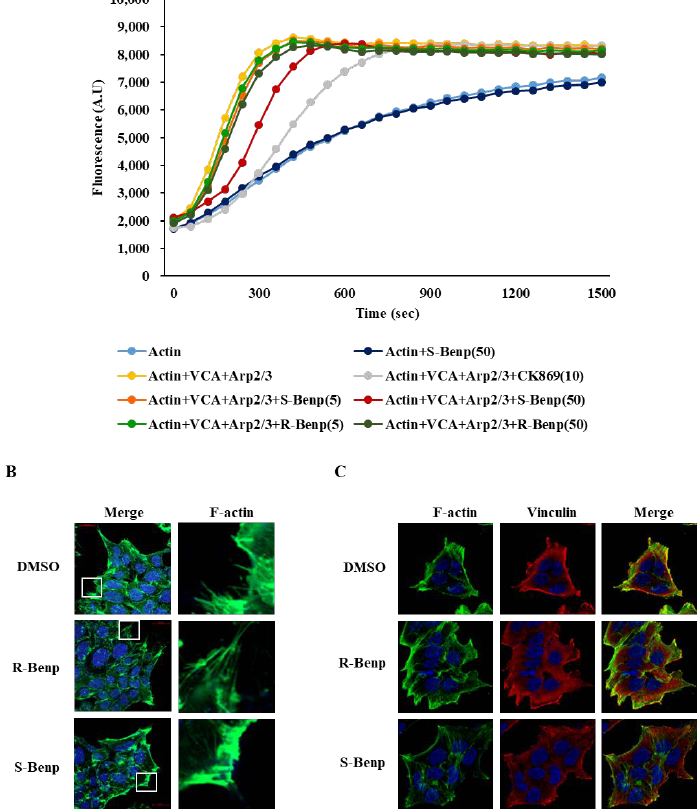
Figure 7. Inhibition of the initiation of actin polymerization and lamellipodia formation by S-Benp. ( A ) Arp2/3-dependent actin polymerizations with VCA with benproperine isomers or CK-869. Polymerized actin was measured by pyrene fluorescence at 365/405 nm ( n = 2). ( B , C ) Confocal images of DLD-1 cells treated with DMSO or R- or S- Benp (2 µM) for 6 h.